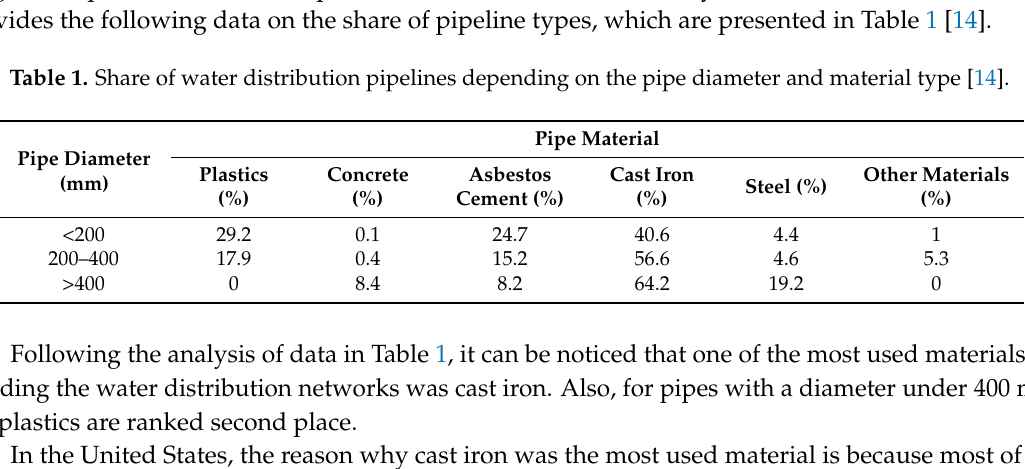
Table 1. Share of water distribution pipelines depending on the pipe diameter and material type [14].